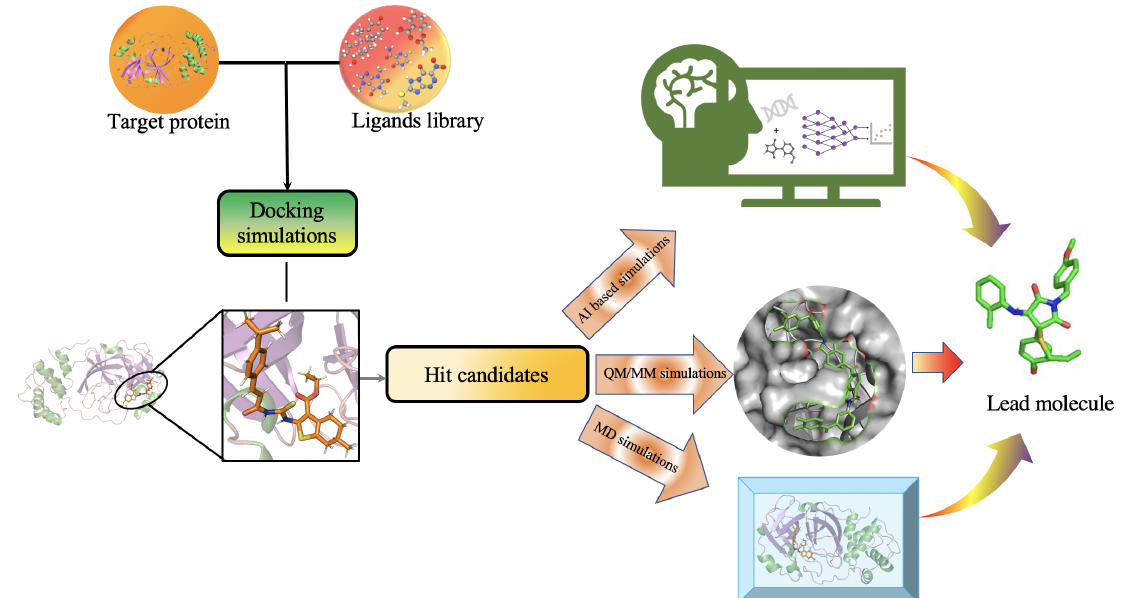
Figure 6. Molecular modeling methods used to study protein–ligand interactions including molecular docking simulations, molecular mechanics methods, hybrid Quantum Mechanics/Molecular Mechanics simulations, and deep learning models for the activity and affinity